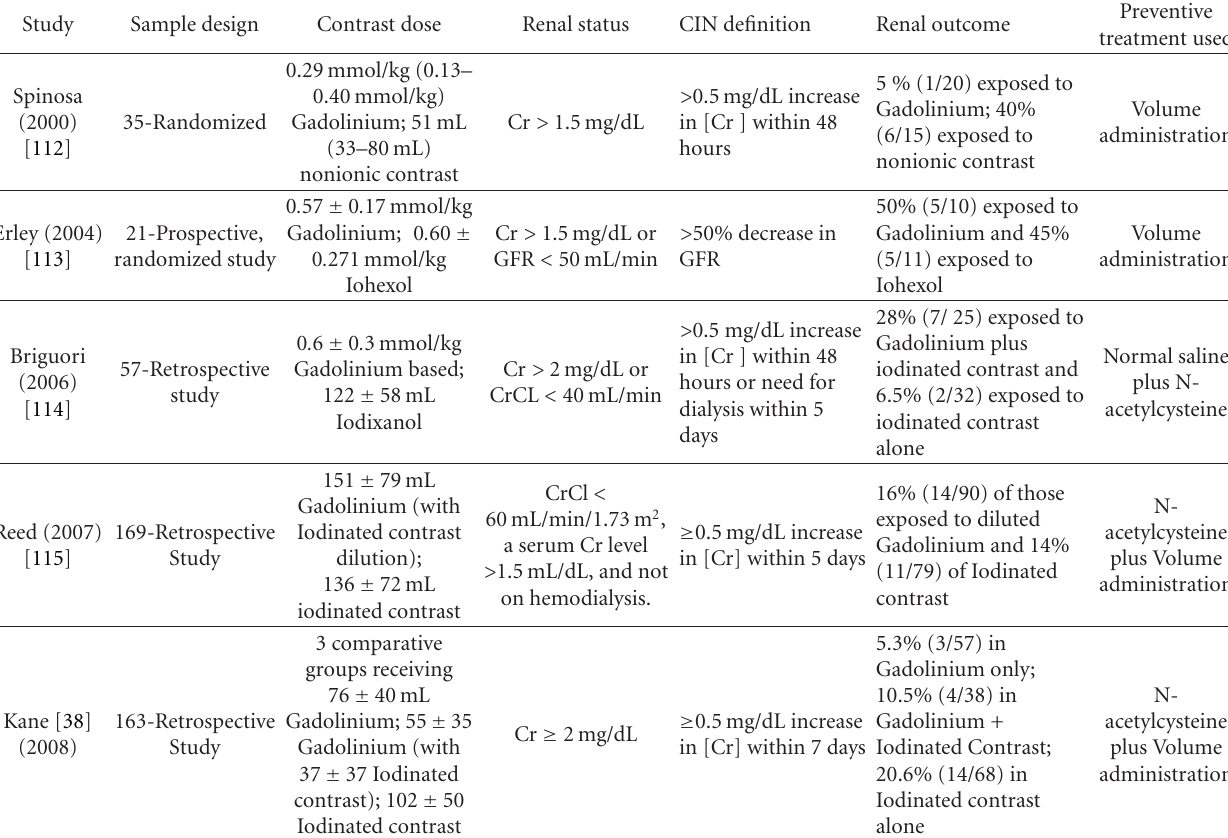
Table 6: Studies assessing incidence of CIN in patients with exposure of gadolinium as